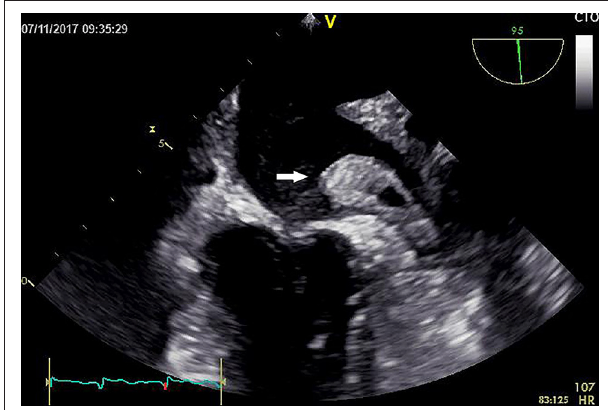
FIGURE 1 | Transesophageal echocardiogram showed the large left atrial thrombus.